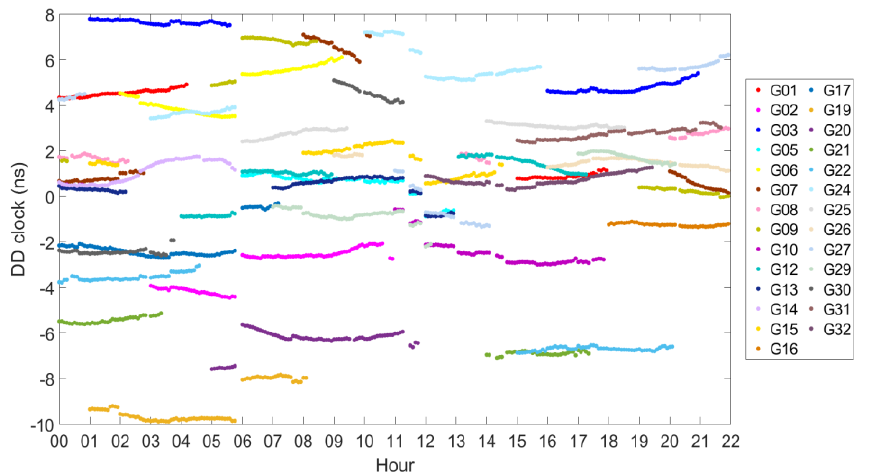
Figure 6. GPS clock offset errors for the PPP-B2b products.